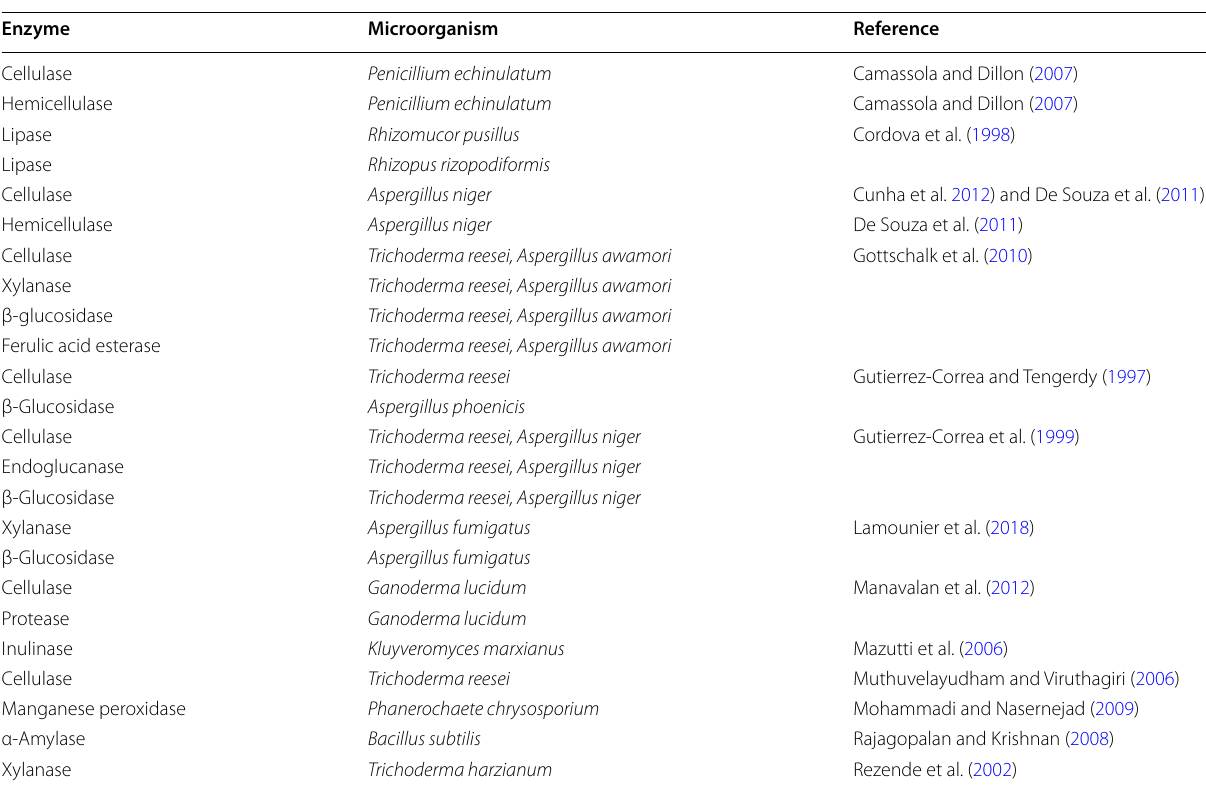
Table 8 List of enzymes produced using SCB as the